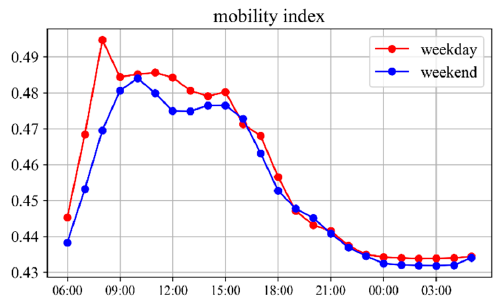
Figure 4. The daily temporal demand pattern between weekdays (red) and weekends (blue).